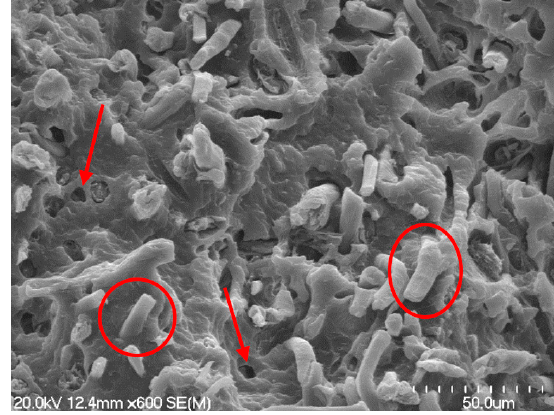
Figure 14. The 20 wt % harakeke filament fracture surface, showing a high degree of fiber dispersion, alignment and pull-out. Circles show fibre pull-out and arrow shows hole from where fibre has been